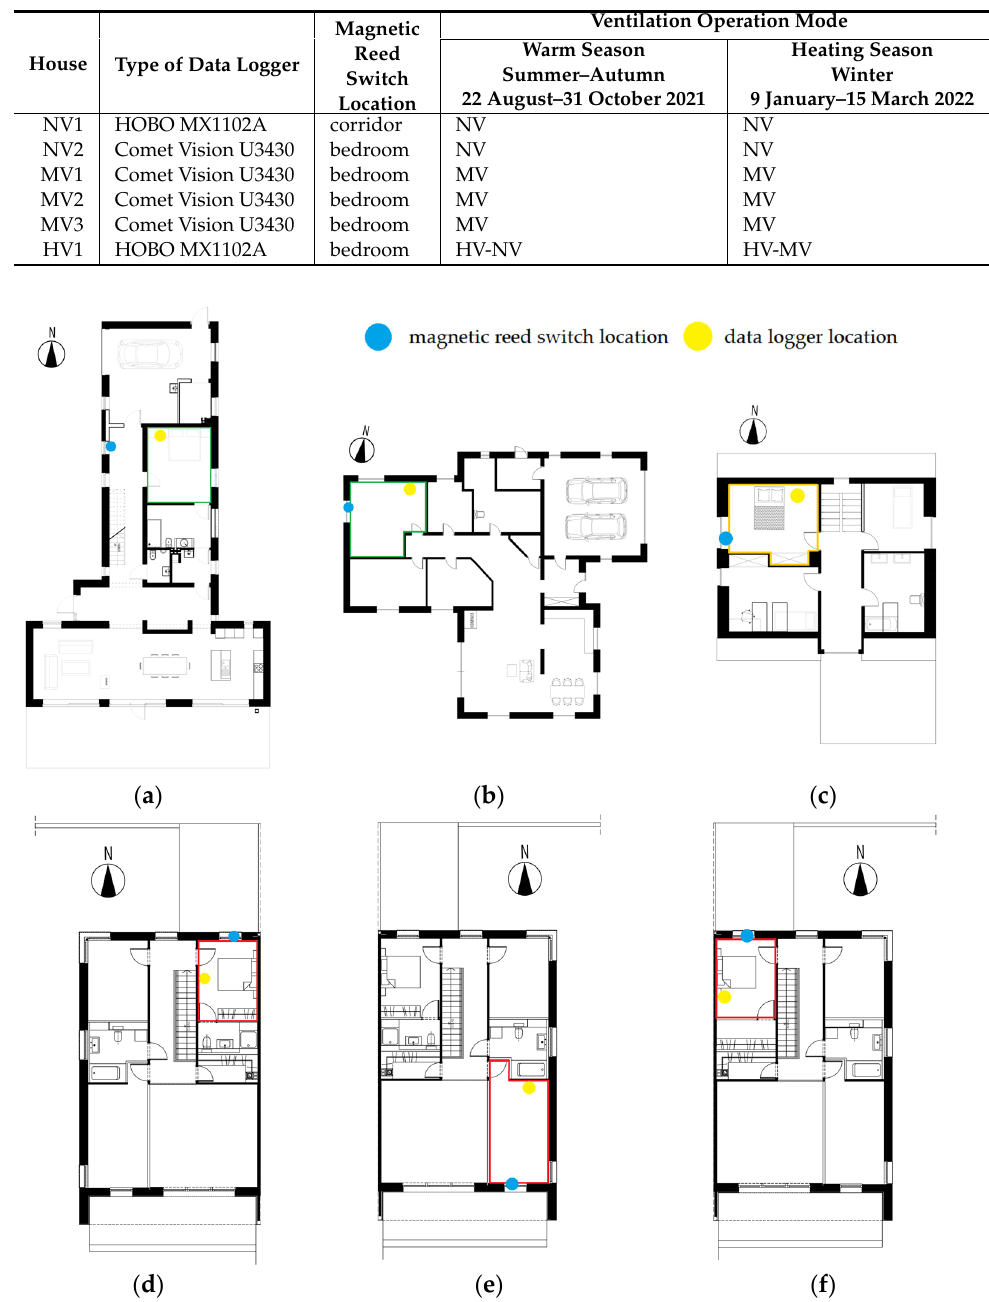
Figure 1. Location of measuring equipment: ( a ) NV1; ( b ) NV2; ( c ) HV1; ( d ) MV1; ( e ) MV2; ( f ) MV3. Table 3. Measuring equipment and operating mode of the ventilation system in buildings. tween 11 p.m. and 7 a.m. The registered air parameters were compared for the selected hours. In the next step, four periods covering three consecutive days were selected, for which a detailed profile of individual parameters was presented against the windows opening